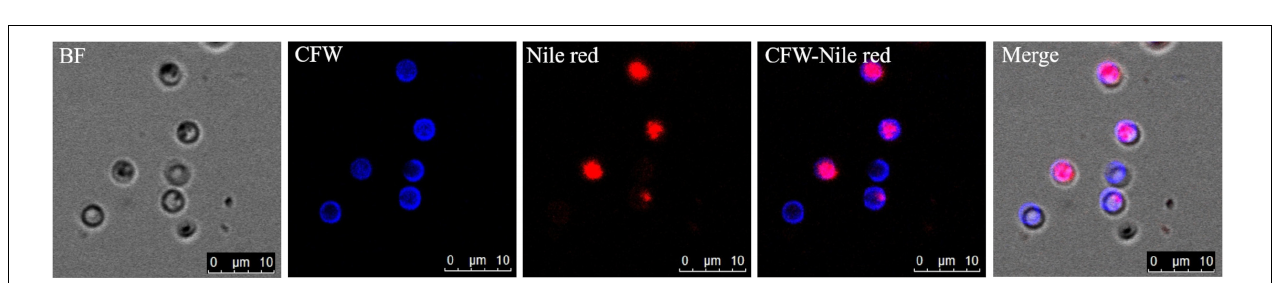
treatments. Perhaps, the speed (or accessibility) of staining also depended on the effect of the treatments on the degree of physical destruction of the spores, e.g., mortality increased with increasing